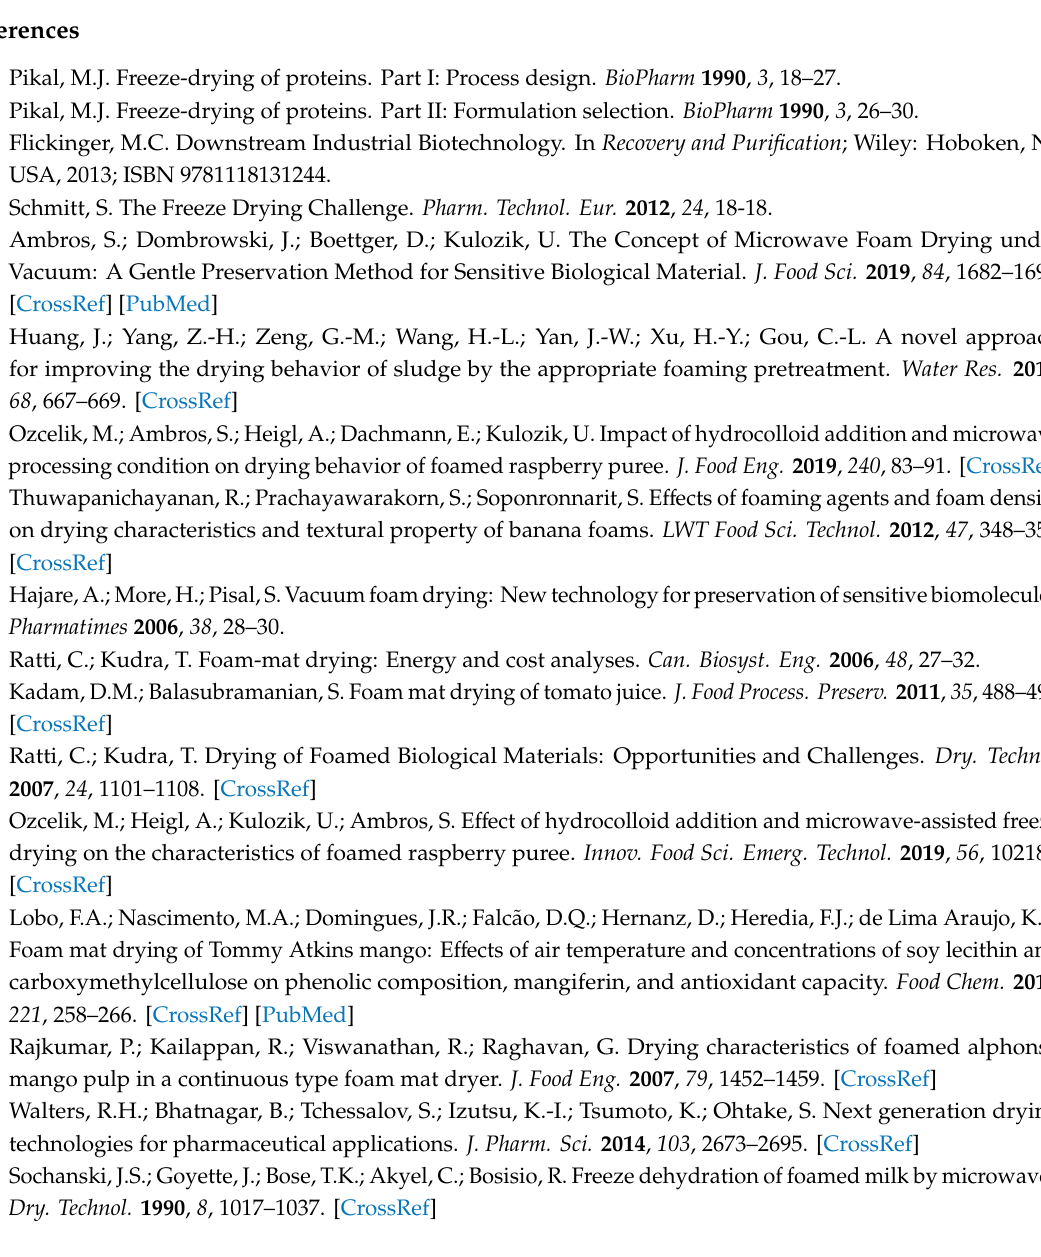
Figure S1: Sublimation rate of foams with MD content between